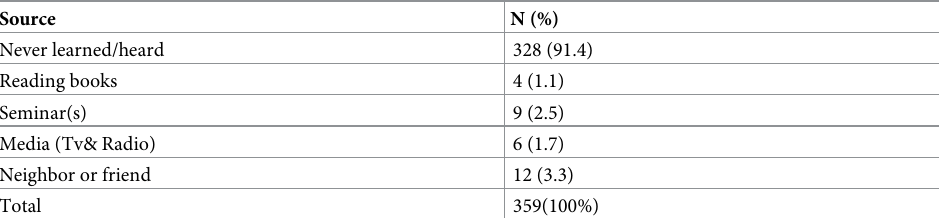
Table 3. Awareness on existence of proper methods for medications